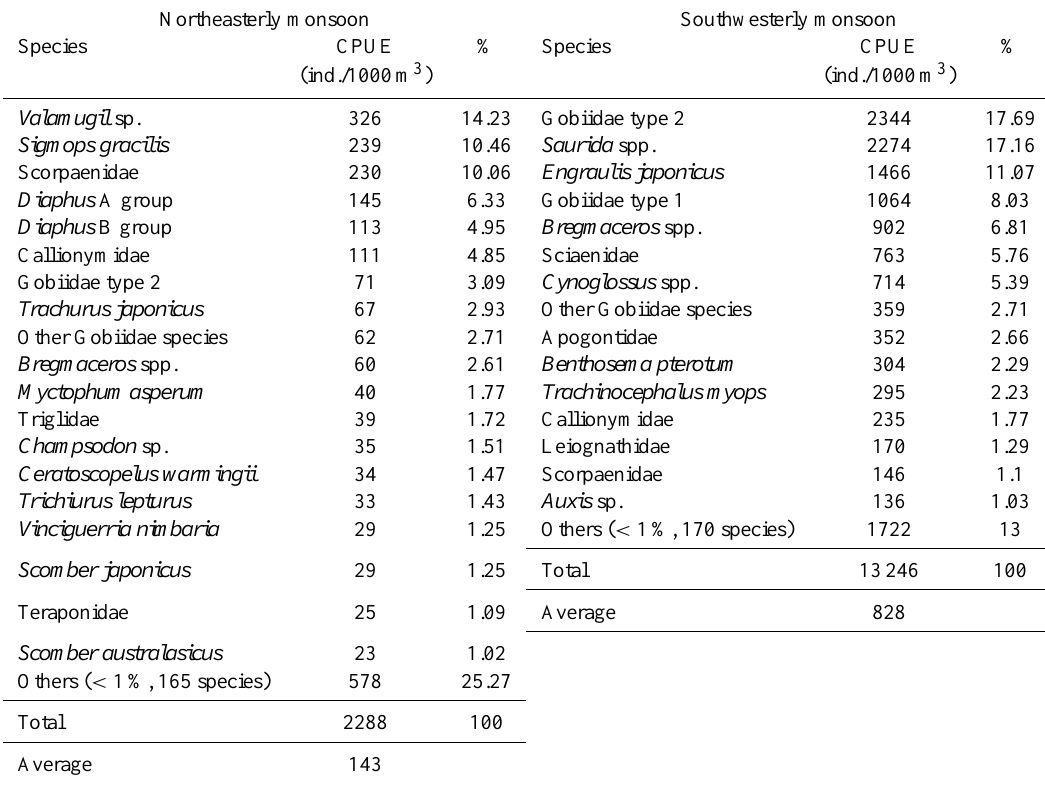
Table 2. Abundance (CPUE, number of individuals/1000m 3 ) of dominant species of larval fish in the northeasterly and southwesterly monsoon seasons in the ECS,